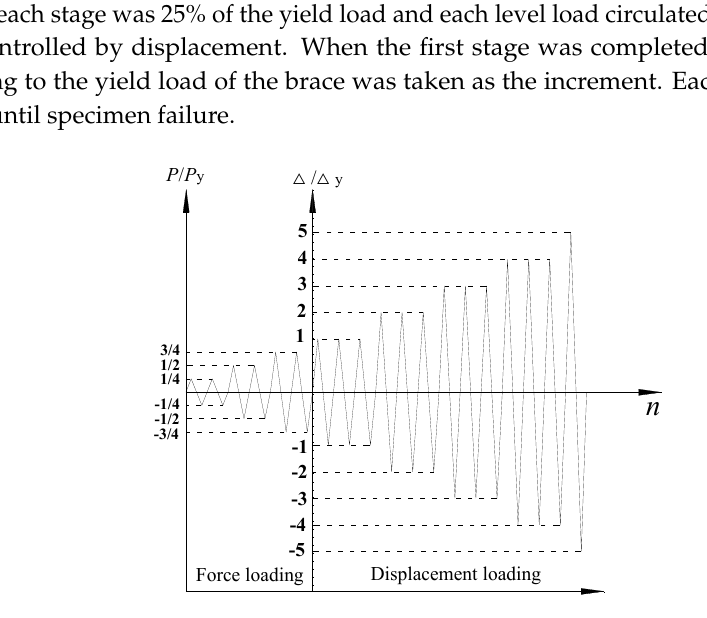
Figure 4. Loading device for cyclic loading.